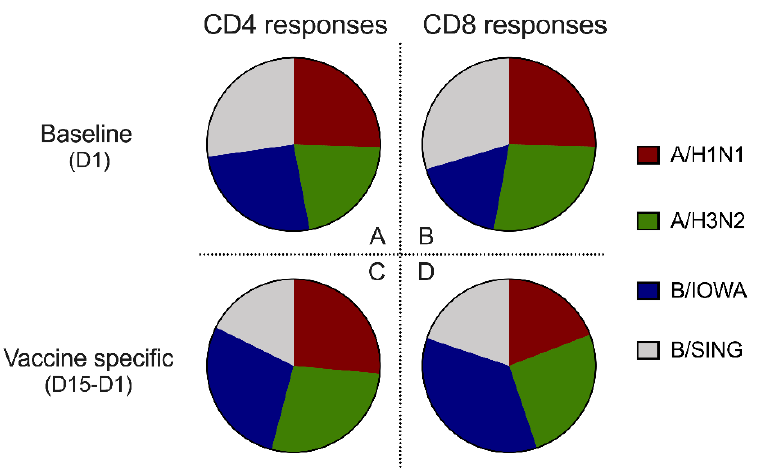
Figure 2. Contributions of all four influenza viruses strains to the cellular immune responses. ( A , B ) The relative contributions of all four influenza viruses strains to CD4 and CD8 responses at baseline (D1) for all 10 participants. ( C , D ) The relative contributions of all four influenza virus strains to vaccine-specific CD4 and CD8 responses (D15–D1) for all 10 participants. ( A – D ) CD4 and CD8 T cell responses were measured by number of influenza virus reactive, cytokine producing CD154+ CD4 or CD8 T cells per million of total CD4 or CD8 T cells, and vaccine specific T cell responses (D15–D1) were calculated by the CD4/CD8 T cells responses at D15 minus baseline CD4/CD8 responses at D1. Data were compared with one-way ANOVA adjusted with Tukey’s test for multiple comparisons, no statistical significance was found between strains.